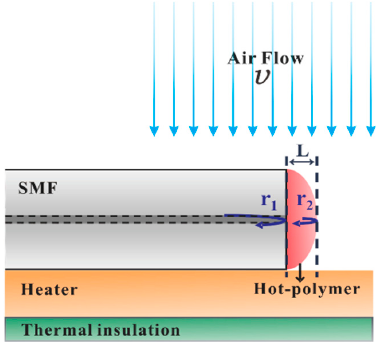
Figure 1. Proposed hot-polymer fiber Fabry–Perot interferometer (HPFFPI) anemometer.